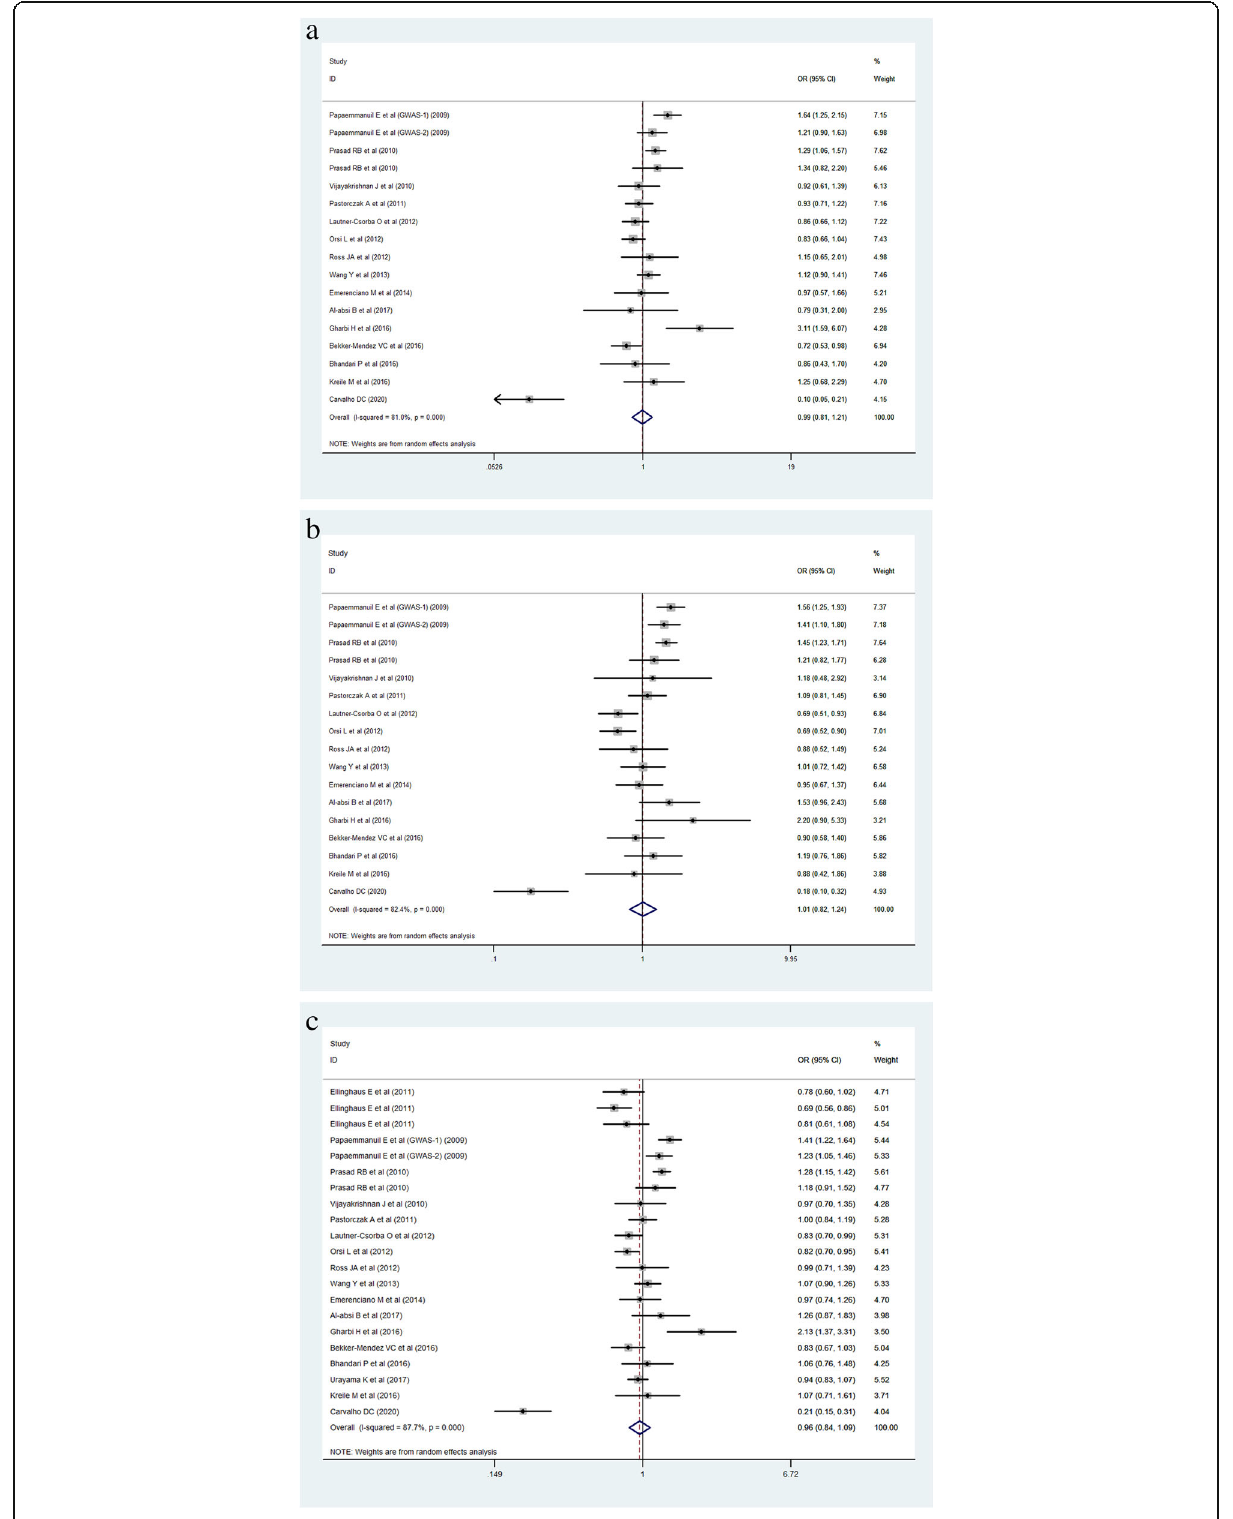
Fig. 1 The flow sheet of identification of eligible